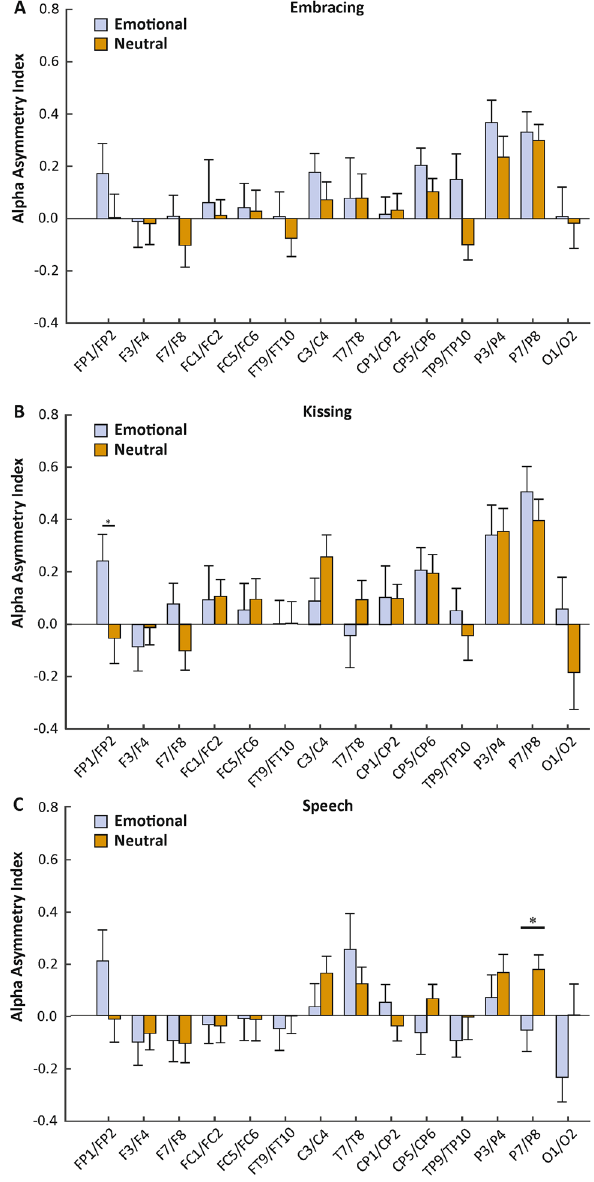
Figure 3. Electrode-specific analysis of alpha power asymmetries during the three behavioral tasks ( A : Embracing, B : Kissing, C : Speech) in the emotional and neutral conditions. Error bars represent